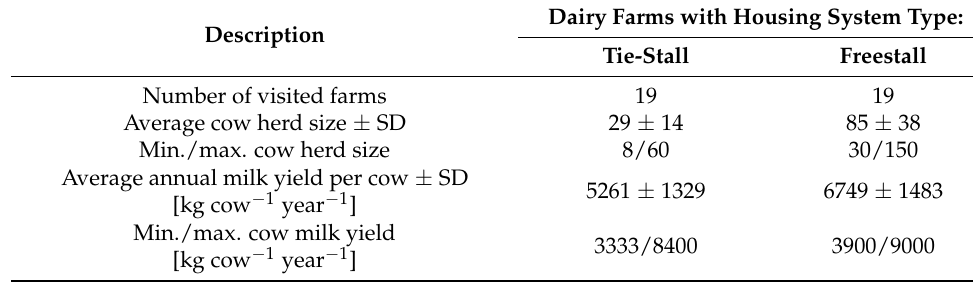
Table 1. Production data of cow herds in the investigated dairy farms. Dairy Farms with Housing System Type: Description Tie-Stall Freestall Number of visited